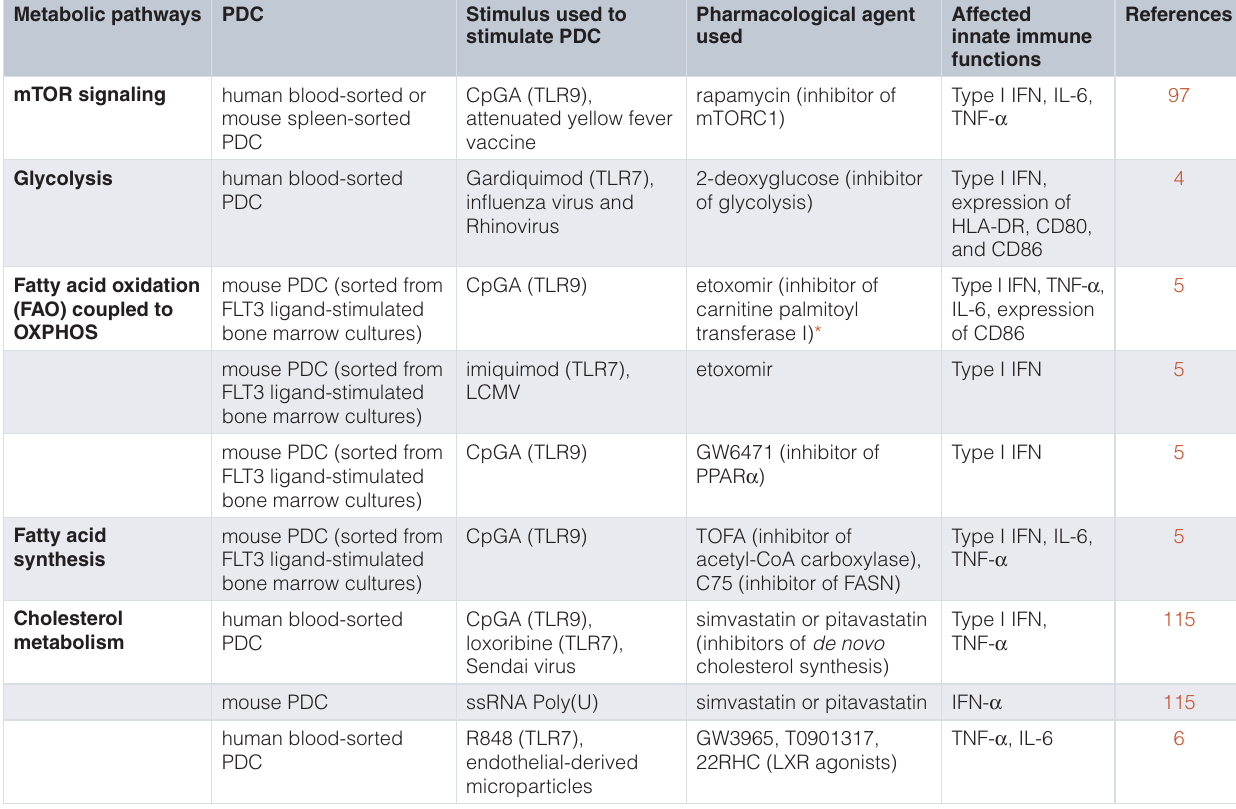
Table 1. Innate immune functions of plasmacytoid dendritic cells are modulated by or dependent on metabolic